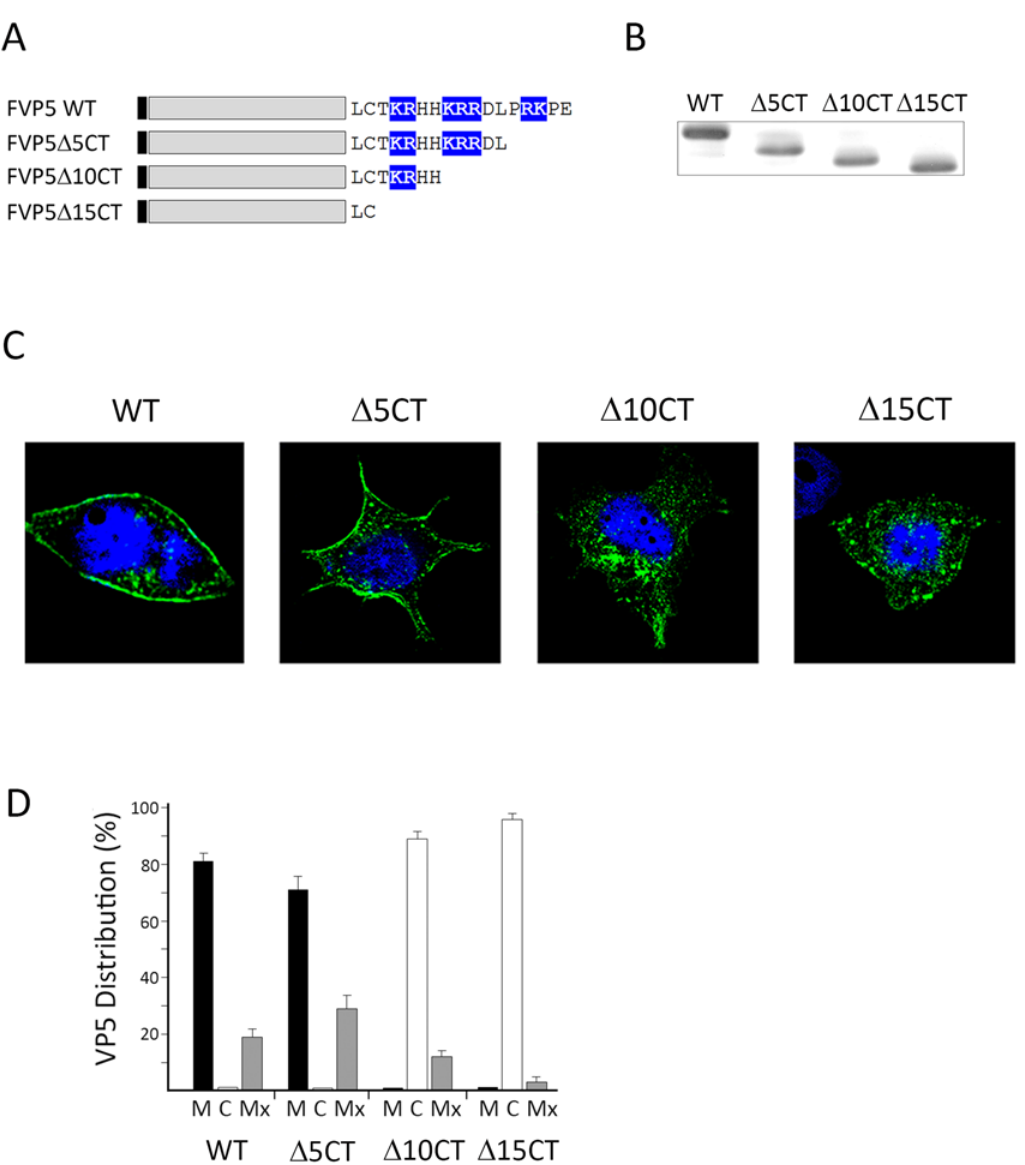
Fig 3. Effect of C-terminal deletions on VP5 PM targeting. A. C-terminal deleted VP5 polypeptides. Diagram depicting the wild type Flag-tagged VP5 protein (FVP5WT) and versions of the protein lacking either 5 ( Δ 5CT), 10 ( Δ 10CT) or 15 ( Δ 15CT) C-terminal residues expressed by recombinant VACVs used in this analysis. The black box indicates the position of the Flag tag. Positively-charged amino acid residues at the C-terminal are highlighted in blue. B. Protein expression analysis. Samples from cells infected with recombinant VACVs expressing the different proteins were subjected to SDS-PAGE and Western blot analysis using an anti-Flag mAb. Subcellular VP5 distribution. C. Single cell images. Coverslips containing cells infected with the different recombinant VACVs were processed for IF using a mouse anti-Flag mAb followed by incubation with goat anti-mouse coupled to Alexa-488 (Green). Nuclei were stained with DAPI (Blue). Cells were visualized by CLSM. Fluorescence signals were recorded separately by using appropriate filters. Images correspond to confocal sections showing the overlay of the two fluorescence signals, and are characteristic examples of the GFP-specific immunofluorescence observed in cells infected with the different recombinant VACVs. D. Statistical analysis. Cells showing more than 70% of the total Flag- specific signal at the plasma membrane or the cell cytoplasm were scored as having a predominant plasma membrane (P) or cytoplasmic (C) distribution. The remaining cell fraction was considered as exhibiting a mixed (Mx) plasma membrane/cytoplasmic distribution. Analyses were performed with data collected from three independent experiments using a total of over three hundred single cell images.